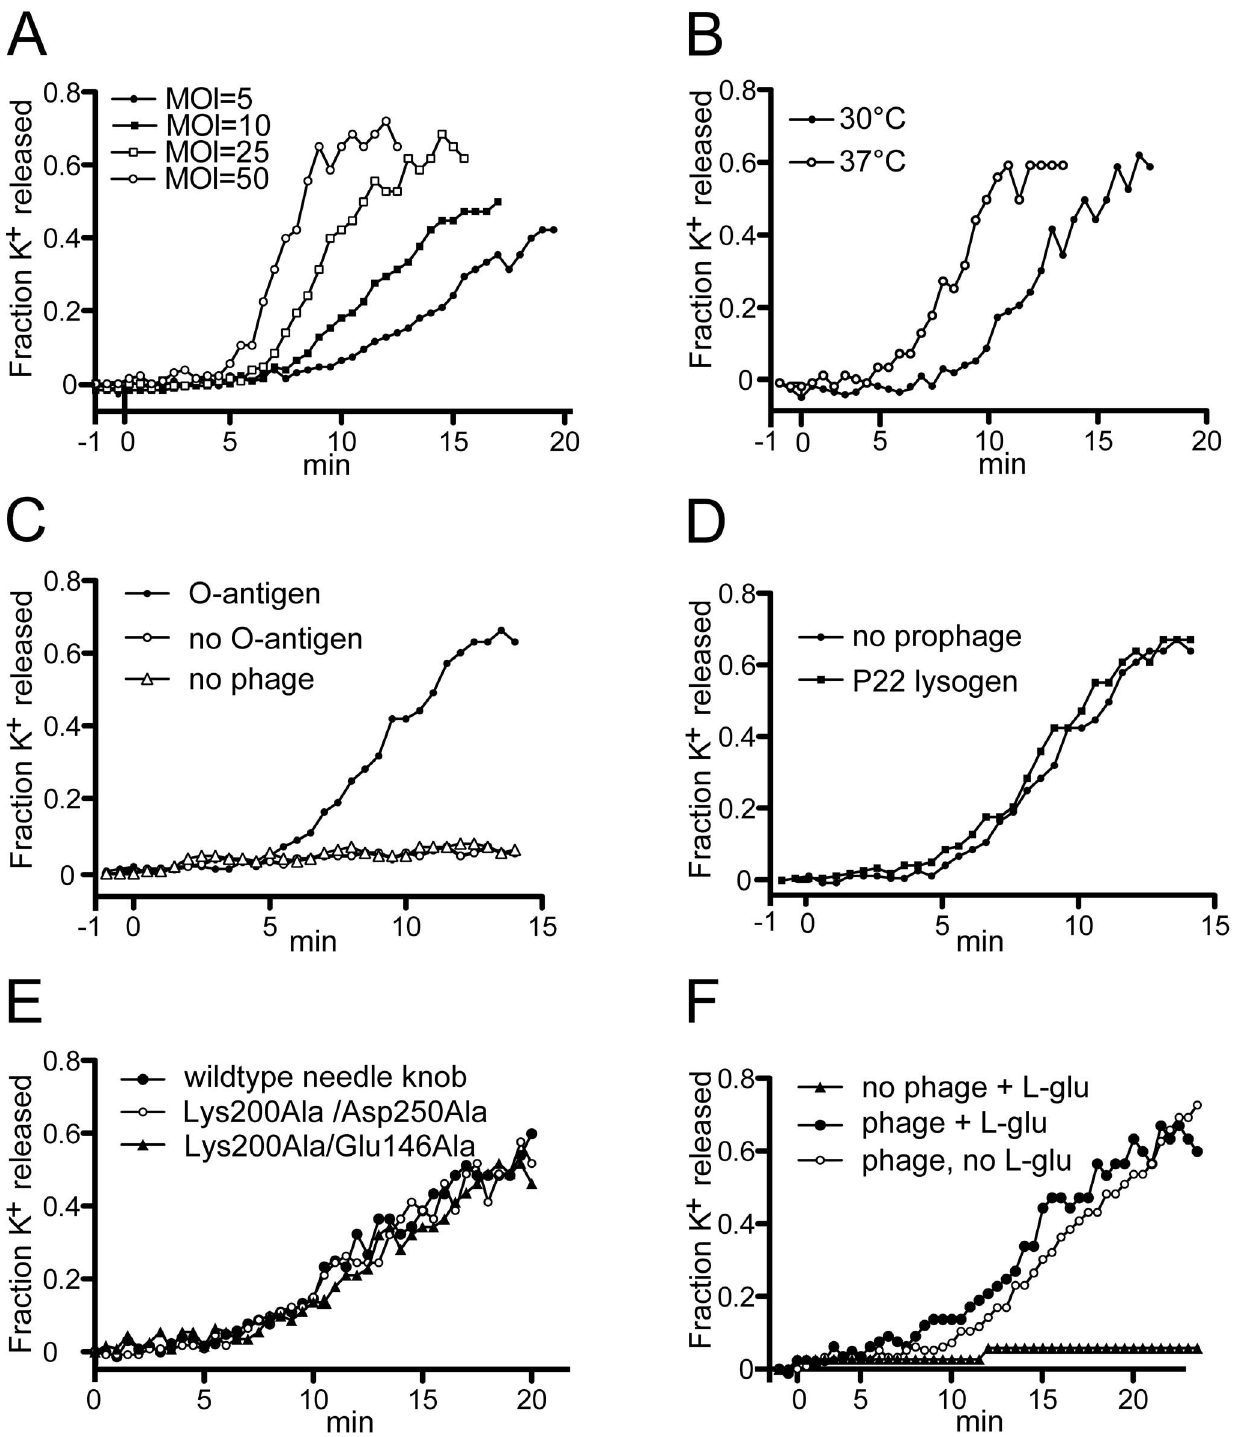
Figure 4. Potassium ion release by phage P22 infection. A. Infection of Salmonella strain UB-0001 by P22 clear mutant phage UC-0011 at different multiplicities of infection (MOIs). Full strain genotypes at given in Table 2 of article text. B. Infection of Salmonella UB-0001 at 30 u and 37 u C by phage P22 UC-0011. C. Infection of Salmonella host strains that have (UB-0001) or do not have (UB-2130) P22’s O-antigen surface polysaccharide receptor by phage P22 UC-011; potassium ion release by uninfected Salmonella UB-0001 is also shown for comparison. D. Infection of a Salmonella host that has no P22 prophage (UB-0001) and a host that carries a P22 prophage that expresses its repressor ( c2 ) gene but is missing the sieA and gtrABC genes (UB-0134) by P22 UC-0011. E. Infection of Salmonella UB-0001 by P22 phages that carry two mutations in the tail needle knob that should abrogate L-glutamate binding (see Table 2 of article text for amino acid changes). All infections were carried out at 30 u C and MOI of 10 unless otherwise indicated. F. Infection of Salmonella UB-0001 by P22 UC-0011 with and without 10 mM L-glutamate added to the medium outside of the cells. Potassium ion measurements were performed as described in Materials and Methods of article text.